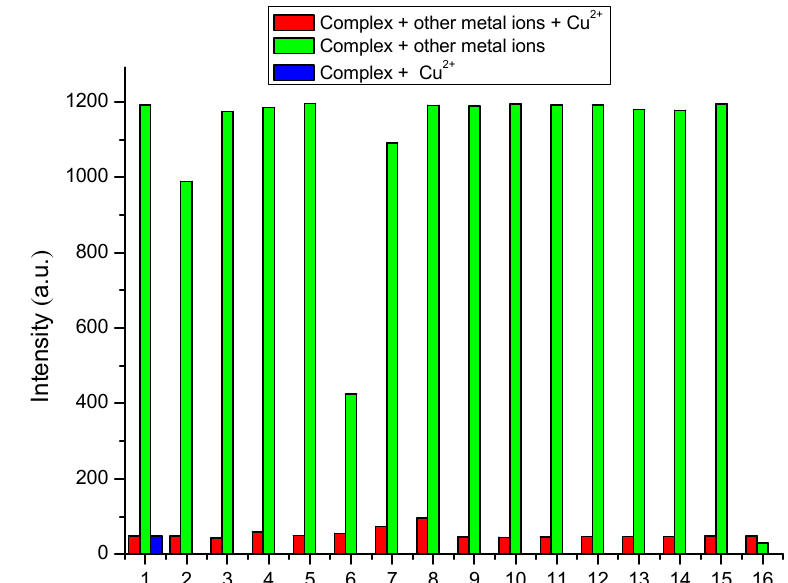
Figure 3. Changes in the fluorescence intensity of the complex [{Ru(bpy) 2 } 2 ( µ 2 -H 2 L)] 4 + (10 − 5 mol / L in CH 3 CN / H 2 O = 1:1, v / v , excitation wavelength = 450 nm) upon the addition of Cu 2 + in the presence of other metal ions. The red bars represent the fluorescence intensity of [{Ru(bpy) 2 } 2 ( µ 2 -H 2 L)] 4 + upon the addition of 5.0 equiv. of Cu 2 + in the presence of: 1 Cd 2 + , 2 Pb 2 + , 3 Ca 2 + , 4 Mg 2 + , 5 Zn 2 + , 6 Hg 2 + , 7 Fe 2 + , 8 Ba 2 + , 9 Ni 2 + , 10 Li + , 11 Mn 2 + , 12 Cr 3 + , 13 Na + , 14 Co 2 + , 15 Ag + , 16 Fe 3 + ; the green bars represent the changes in the fluorescence intensity of [{Ru(bpy) 2 } 2 ( µ 2 -H 2 L)] 4 + upon the addition of other metal ions, respectively. The blue bar represents the fluorescence intensity of [{Ru(bpy) 2 } 2 ( µ 2 -H 2 L)] 4 + when 5.0 equiv. of Cu 2 + were